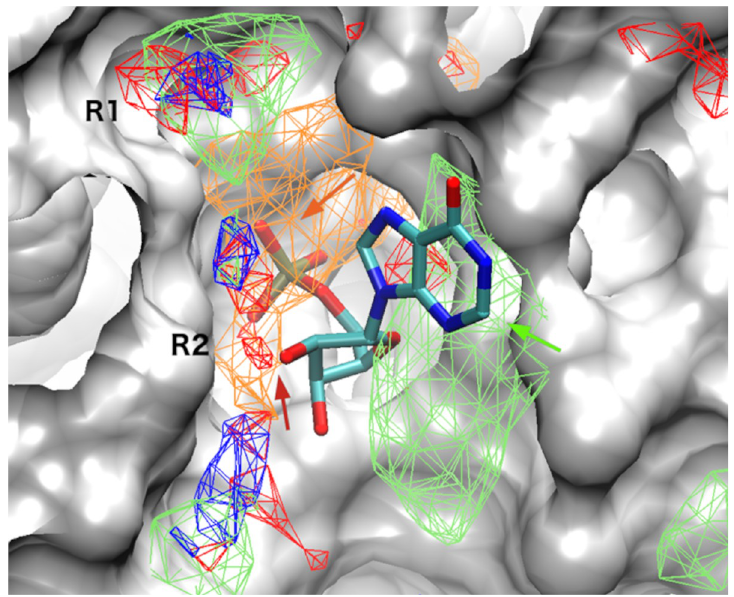
Fig 2. Apolar (green), hydrogen bonding donor (blue) and acceptor (red) and negatively (orange) charged SILCS FragMaps overlaid on the active site of CMY-10. The crystal binding mode of IMP in the CMY-10-IMP complex is shown. Consistencies between the crystal binding mode of IMP with FragMaps are shown by